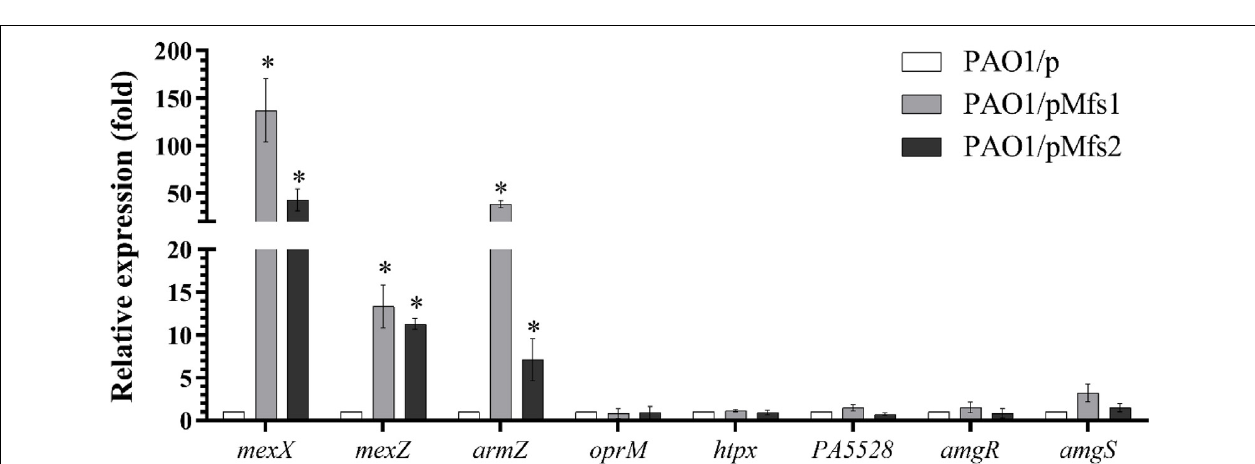
FIGURE 3 | Expression of mexX and aminoglycoside [gentamicin (CN) and tobramycin (TOB)] or quinolone [ciprofloxacin (CIP) and levofloxacin (LEV)] MICs against PAO1 / pMfs1 and PAO1 / pMfs2 and various truncated derivatives. Mfs1 and Mfs2 membrane topology were generated from SOSUI (Hirokawa et al., 1998; Mitaku and Hirokawa, 1999; Mitaku et al., 2002). MICs data shown are the modes of seven independent experiments. Gene expression analysis data are present in means ± SD of three biological replicates. Asterisk ( ∗ ) indicates significant difference relative to PAO1 / p ( p -value < 0.05).